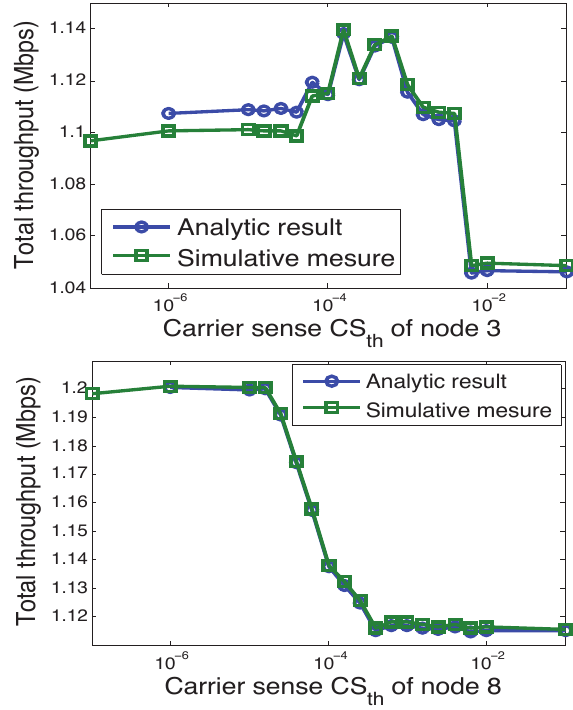
Figure 13. End-to-end throughput from model versus simulation for variable carrier sense threshold (in